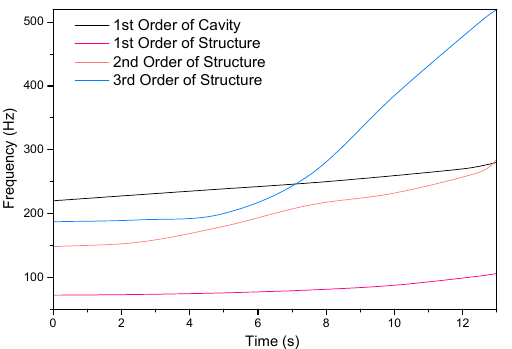
Figure 16. Natural frequencies of the acoustic cavity and the shell structure over working time.